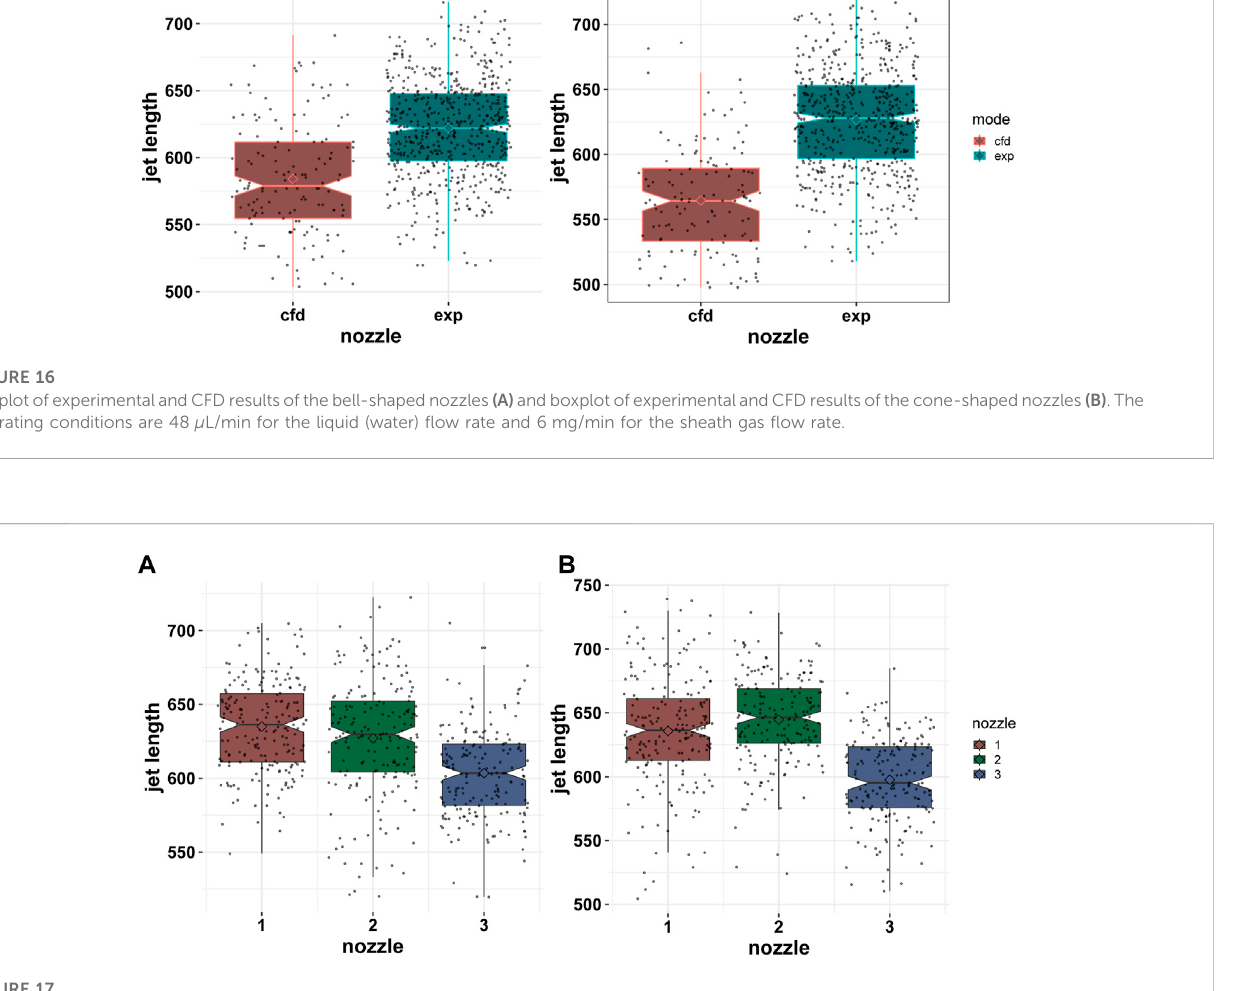
FIGURE 17 Boxplot of experimental results of three bell-shaped nozzles (A) and boxplot of experimental results of three cone-shaped nozzles (B)